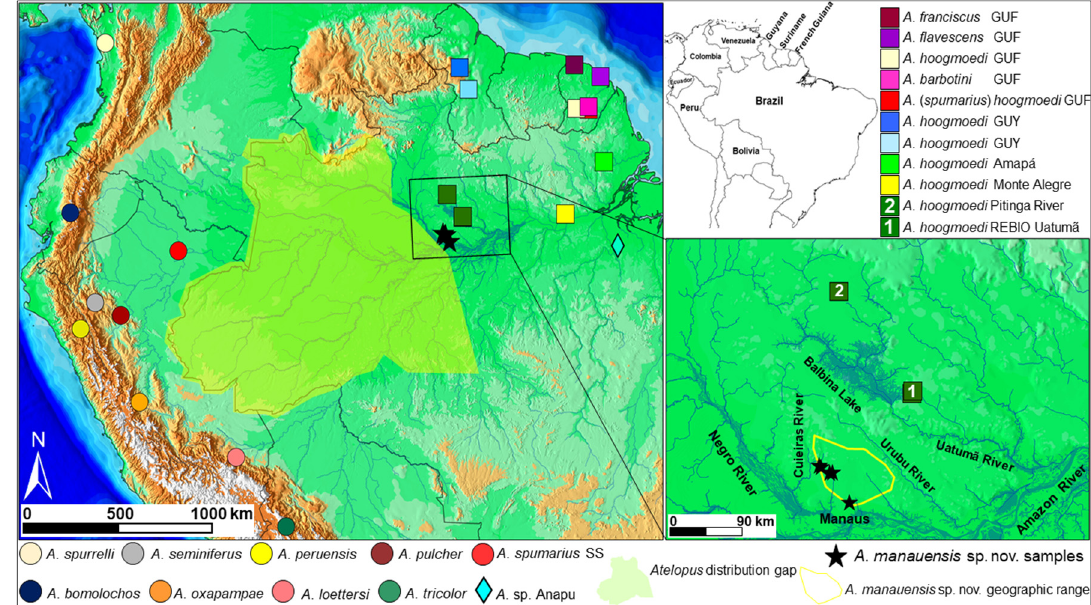
Figure 10. Distribution map for species of Atelopus used in the calculations of genetic distances and phylogenetic inferences, with colored circles representing species distributed to the west of Amazonia, on eastern and western versants of the Andes and Andean highlands; the squares representing species distributed in the Guiana Shield, and the green diamond a candidate species distributed on the south bank of the Amazon River, municipality of Anapu, state of Pará, Brazil [30]. The shaded polygon represents the portion of the Amazonian plain where there has been no record yet of a species of Atelopus , indicating a distribution gap for the genus (adapted from L ӧ tters et al. [32]). Insert in the lower right shows the limits of the geographical distribution of Atelopus manauensis sp. nov. as represented by the yellow polygon between the Urubu and the Cuieiras Rivers; black stars refer to the type of locality where the holotype, allotype, and paratypes (RFAD) and individuals used for the genetics analyses (FEUFAM and LBA/ZF2) of Atelopus manauensis sp. nov. were collected; numbered dark green squares represent populations of Atelopus hoogmoedi of REBIO Uatumã (1) and of Pitinga River (2), on the east bank of the Uatumã River, the geographically closest Atelopus populations to the new species. Two specimens of A . hoogmoedi from REBIO Uatumã were used for genetic analyses.